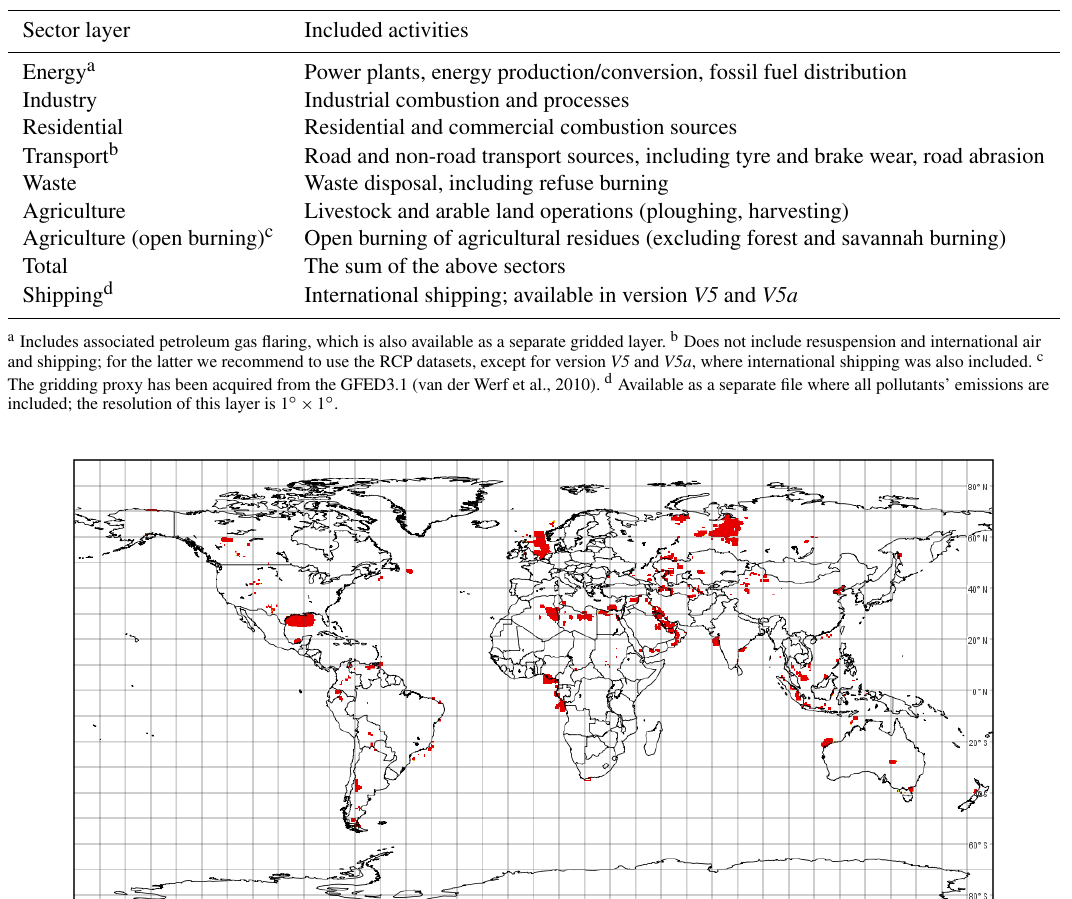
Table 5. Overview of sectoral layers included in the gridded ECLIPSE emissions of PM.